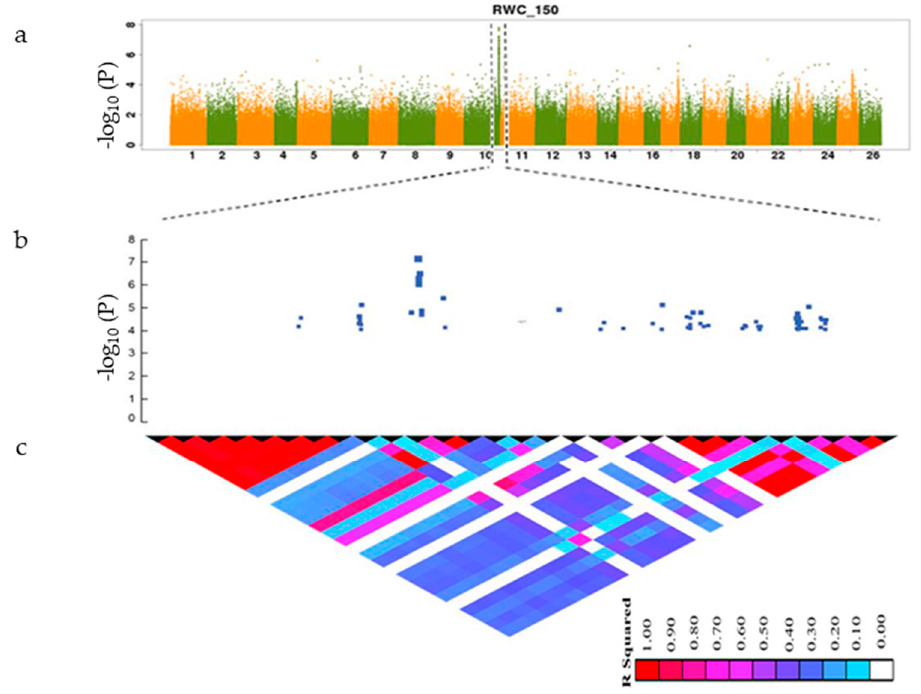
Figure 3. This figure shows the SNPs on all chromosomes and SNPs on chromosome A10 and LD block. ( a ) Manhattan plot of RWC_150. RWC_150 is the value of relative water content under salt stress conditions. X-axis denotes twenty-six chromosomes and y-axis depicts − log 10 p -value; ( b ) local Manhattan plot across the region of chromosome A10 where SNPs were found to be significantly associated with RWC_150; the y-axis is − log 10 p -value; ( c ) linkage disequilibrium block heatmap of RWC_150 triangles shows the r 2 value of SNPs; the red color indicates 1, the white color indicates 0.